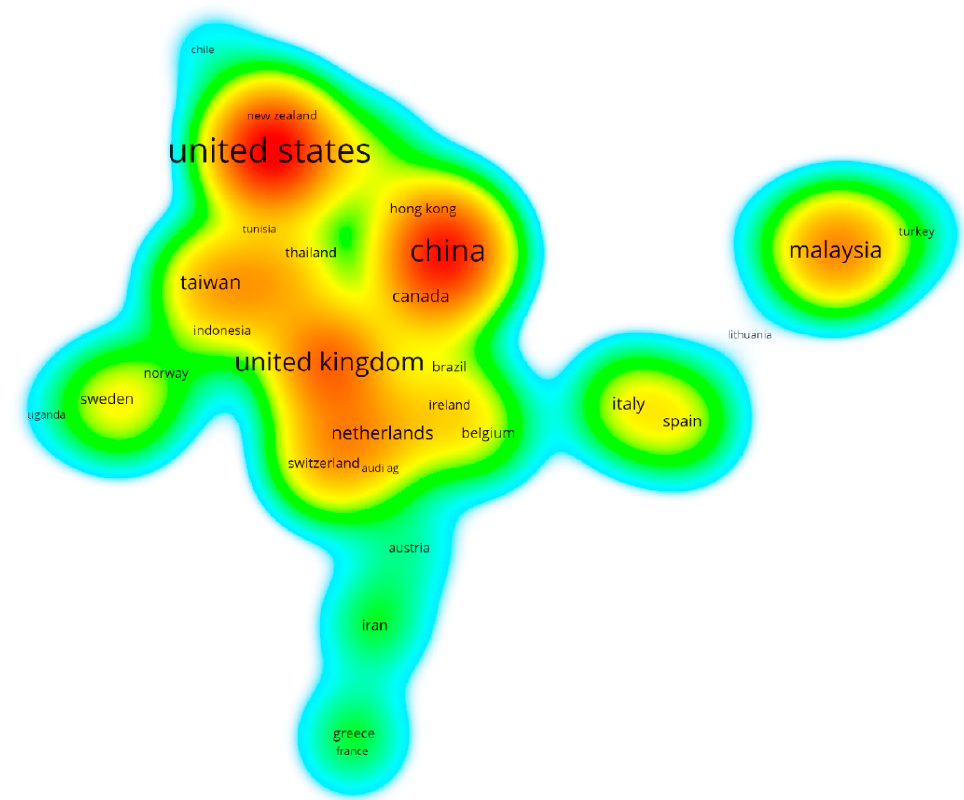
Figure 6. Density of the main source countries and regions. Table 2. Publication characteristics of productive countries and